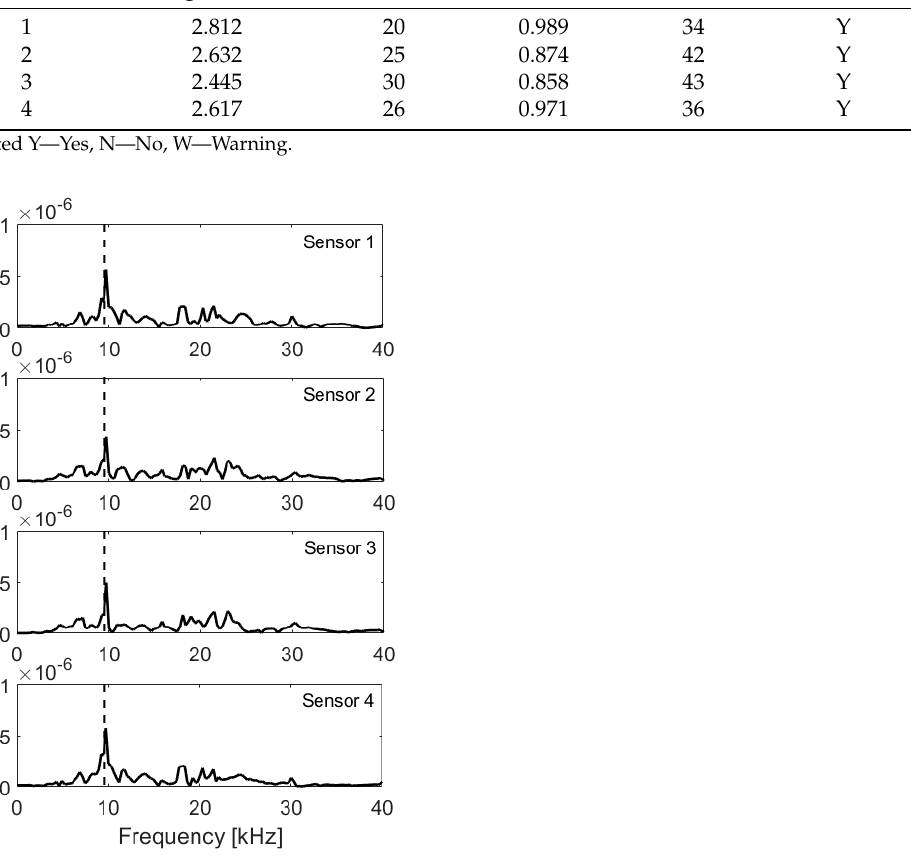
Figure 12. Frequency spectra, edge below impactor; expected frequency marked with dashed line.